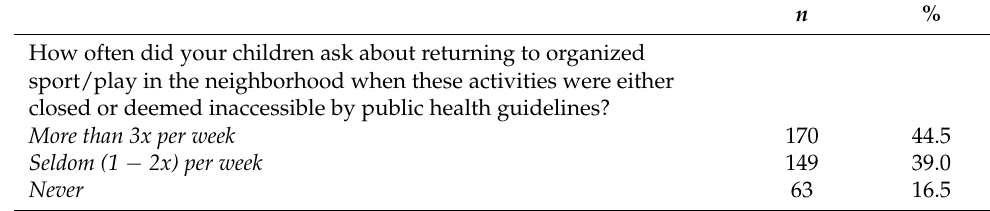
Table 2. Parents’ ( n = 382) Perspectives of their Children’s Physical Activity Experiences and Behaviors.